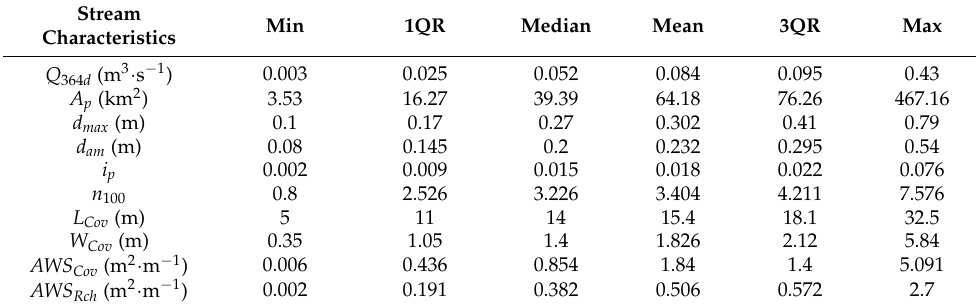
Table 1. Basic statistical characteristics of the data set: 364-day discharge ( Q 364 d ), catchment area to the last profile of the reference reach ( A p ), maximum value of the water depth in the reference reach ( d max ), average maximum depth from all cross sections ( d am ), average longitudinal slope of the water level ( i p ), average number of fish covers (microhabitats) per 100 m of reach ( n 100 ), fish cover length in the flow direction ( L Cov ), fish cover width ( W Cov ), average value of the area-weighted suitability for the monitored fish covers ( AWS Cov ), area-weighted suitability for the monitored reach ( AWS Rch ), minimum values of monitored parameters (Min), variability of the interquartile range using the value of the first quartile (1QR), middle value of the range of monitored data (Median), average values of the monitored parameter (Mean), variability of the interquartile range using the value of the third quartile (3QR), and maximum values of monitored parameters